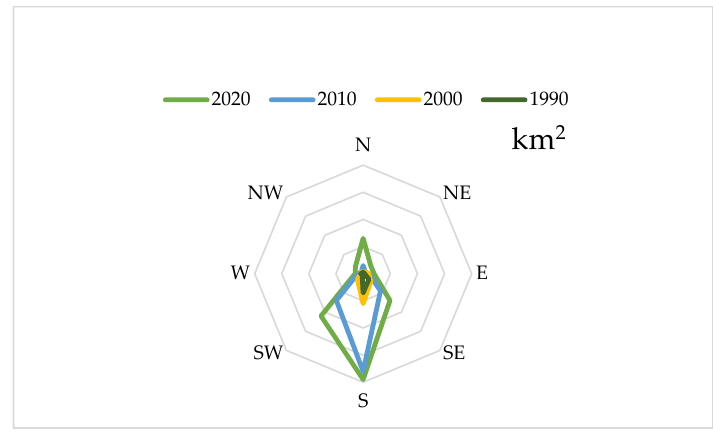
Figure 9. Direction of the built-up land distribution in the study area.